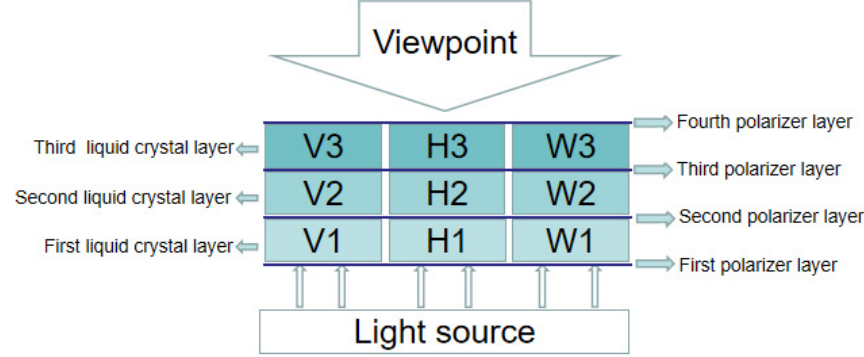
Figure 1. The liquid crystal structure of the processor of the SD16 system.